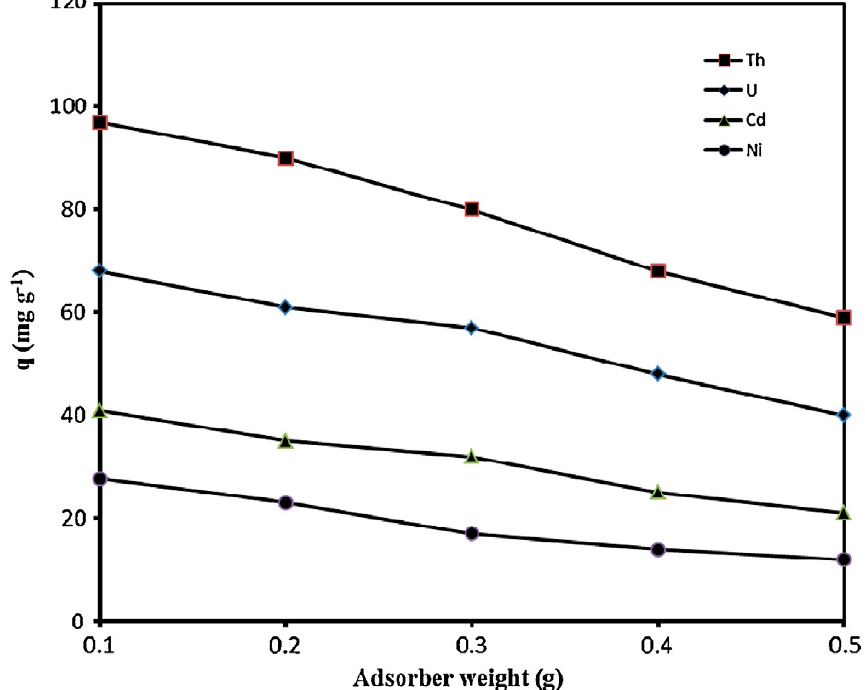
Figure 11. Effect of adsorbent dosage on the adsorption of metal ions. Adapted with permission from reference [129].